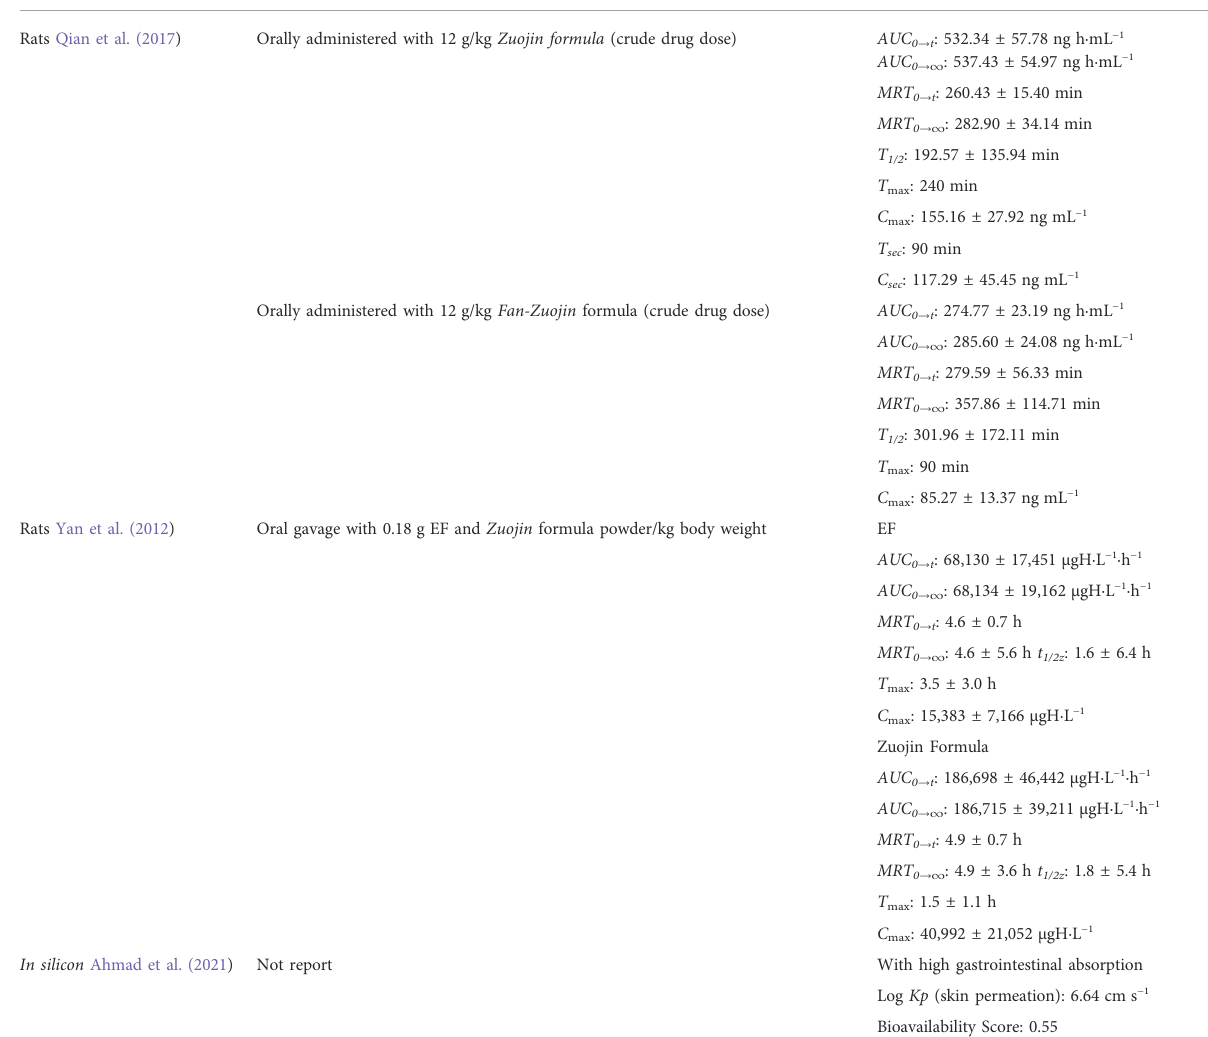
Oral gavage with 0.18 g EF and Zuojin formula powder/kg body